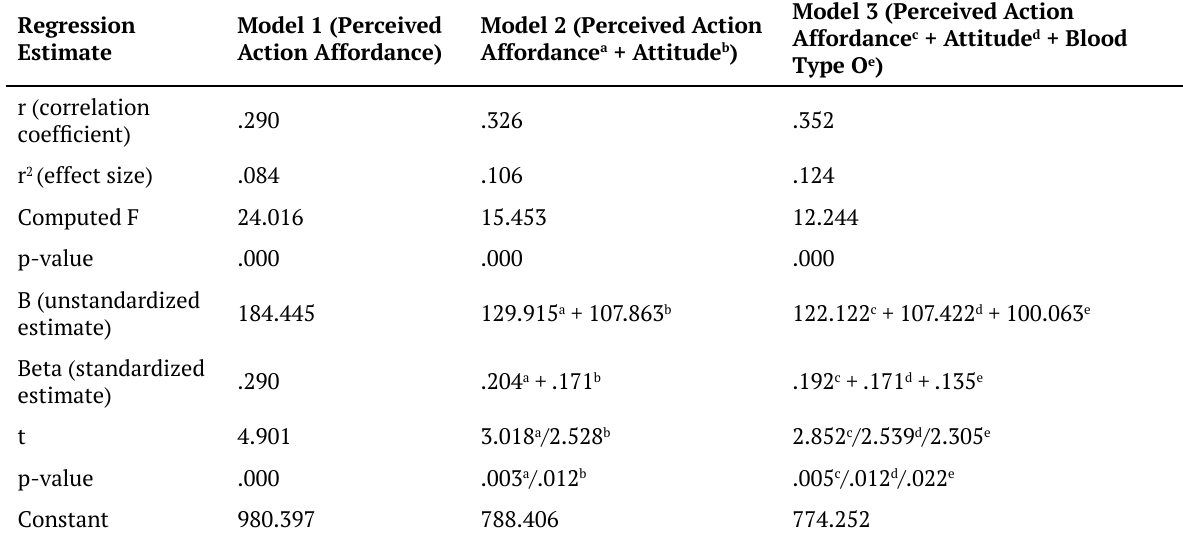
Table 12. Regression estimation procedures of the factors towards participants’ endurance